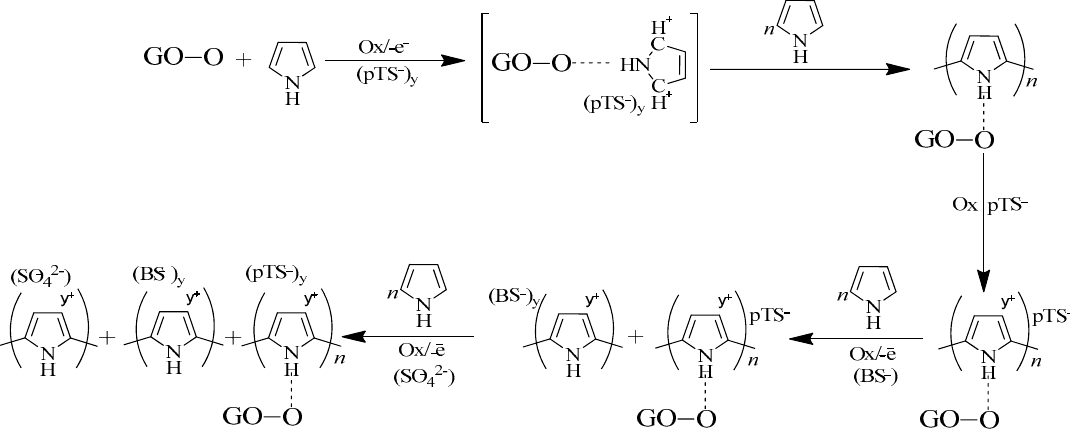
Figure 14. Mechanism of polypyrrole (PPy) multilayer films deposition on graphene oxide [78].